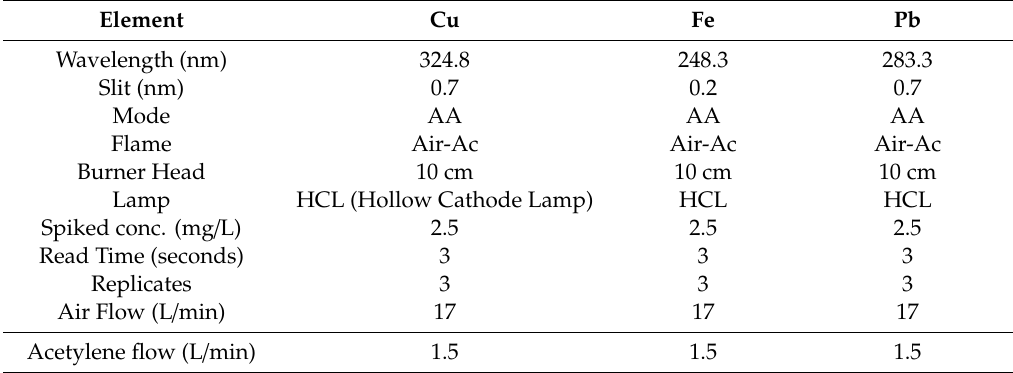
Table 1. AAS (Atomic Absorption Spectroscopy) parameters used for analysis.